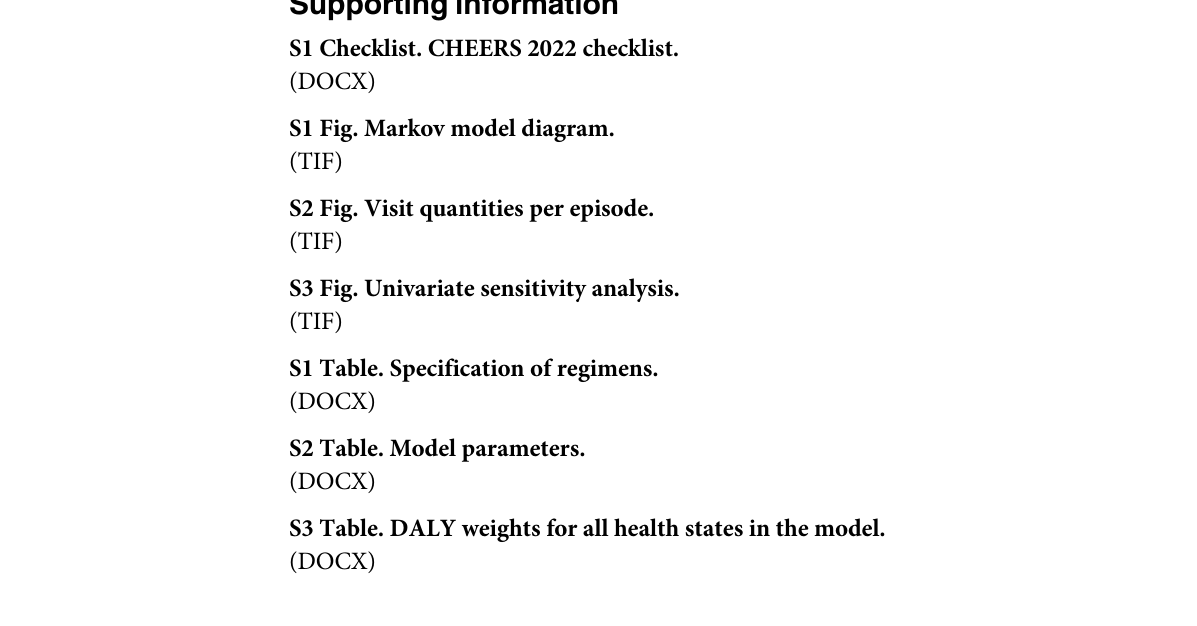
S1 Fig. Markov model diagram.